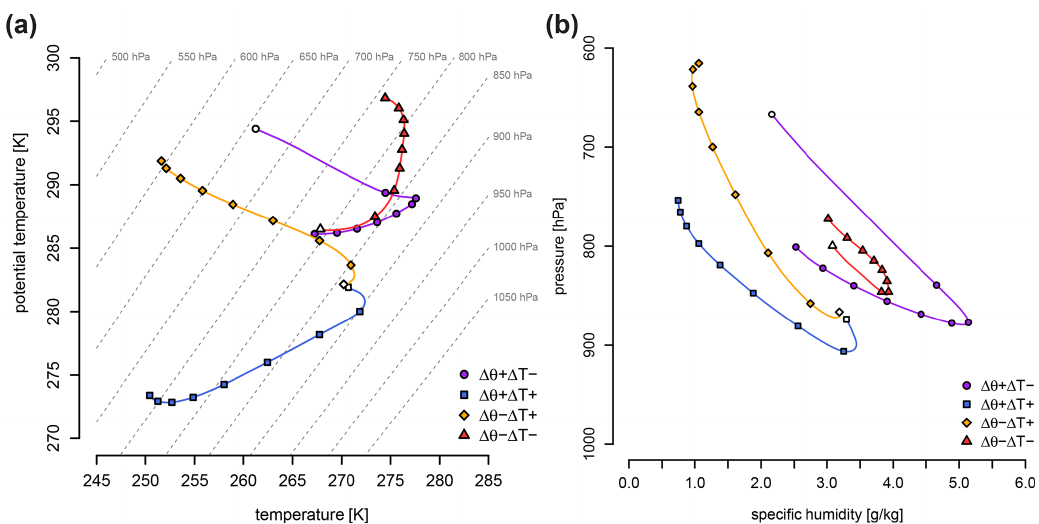
Figure 5. (a) θ − T diagrams showing the evolution of θ and T averaged over the trajectories in each category with symbols every 24h and time of arrival at 70 ◦ N ( t = 0h) indicated by white filled symbols. Gray dashed lines show isobars. (b) Same as panel (a) but for the evolution of specific humidity vs. pressure.